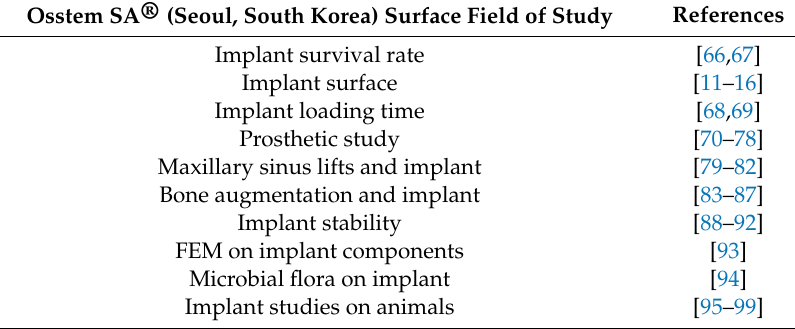
Table 2. Topics of SA surface studies.